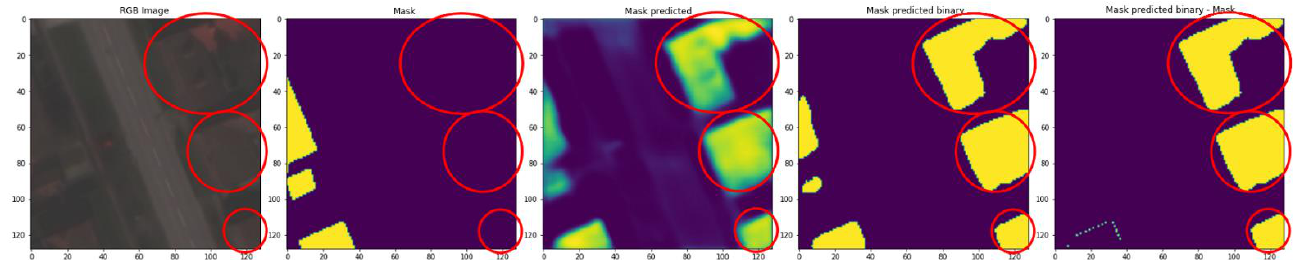
Figure 23. Correctly identified objects that were not in the training set—Subotica.